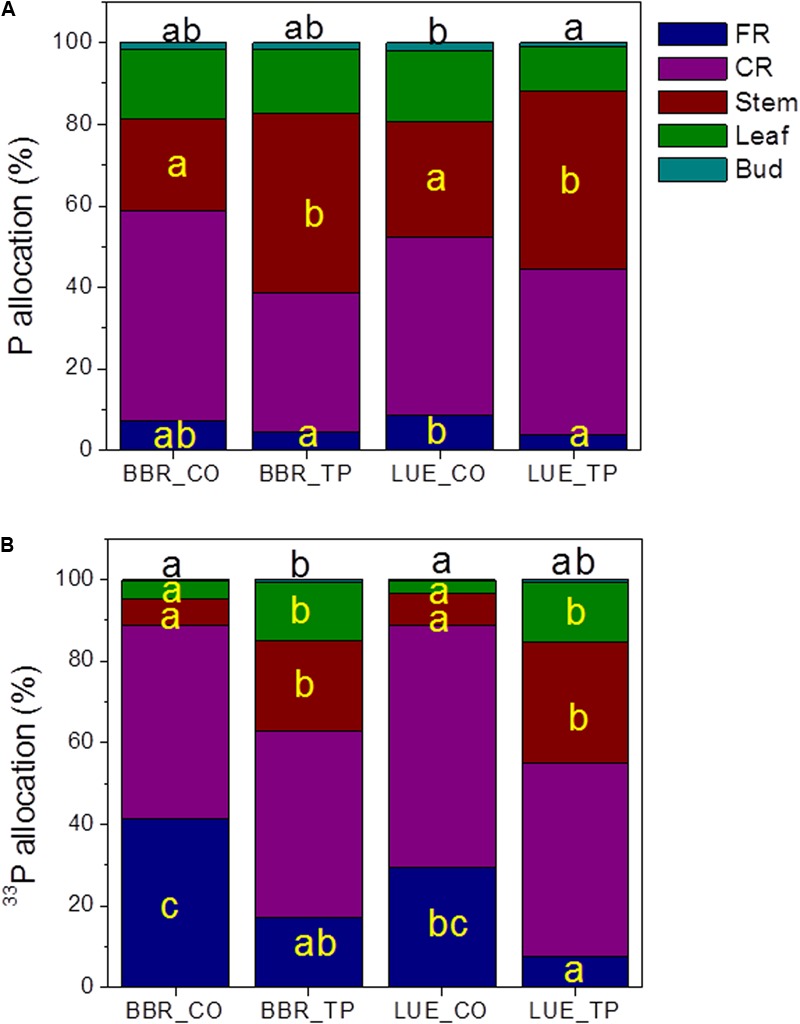
Whole-plant Ptot
(A) and 33P (B) allocation in European beech trees (Fagus sylvatica L.) in P-rich (BBR) or P-poor soil (LUE) without (CO) or with application of TP fertilizer. The contents of P (mg) and of 33P (Bq) were determined for each tissue 1 week after application of the radioactive label. For each plant, the sum of the tissue Ptot contents, respective the sum of the 33P contents was set as 100%. Data indicate means (n = 5 per soil type and P treatment). Significant differences among the tissues at p < 0.05 are indicated by different letters. Black letters on top of the stacked bars refer to buds. Tissues without letters did not show any significant difference.